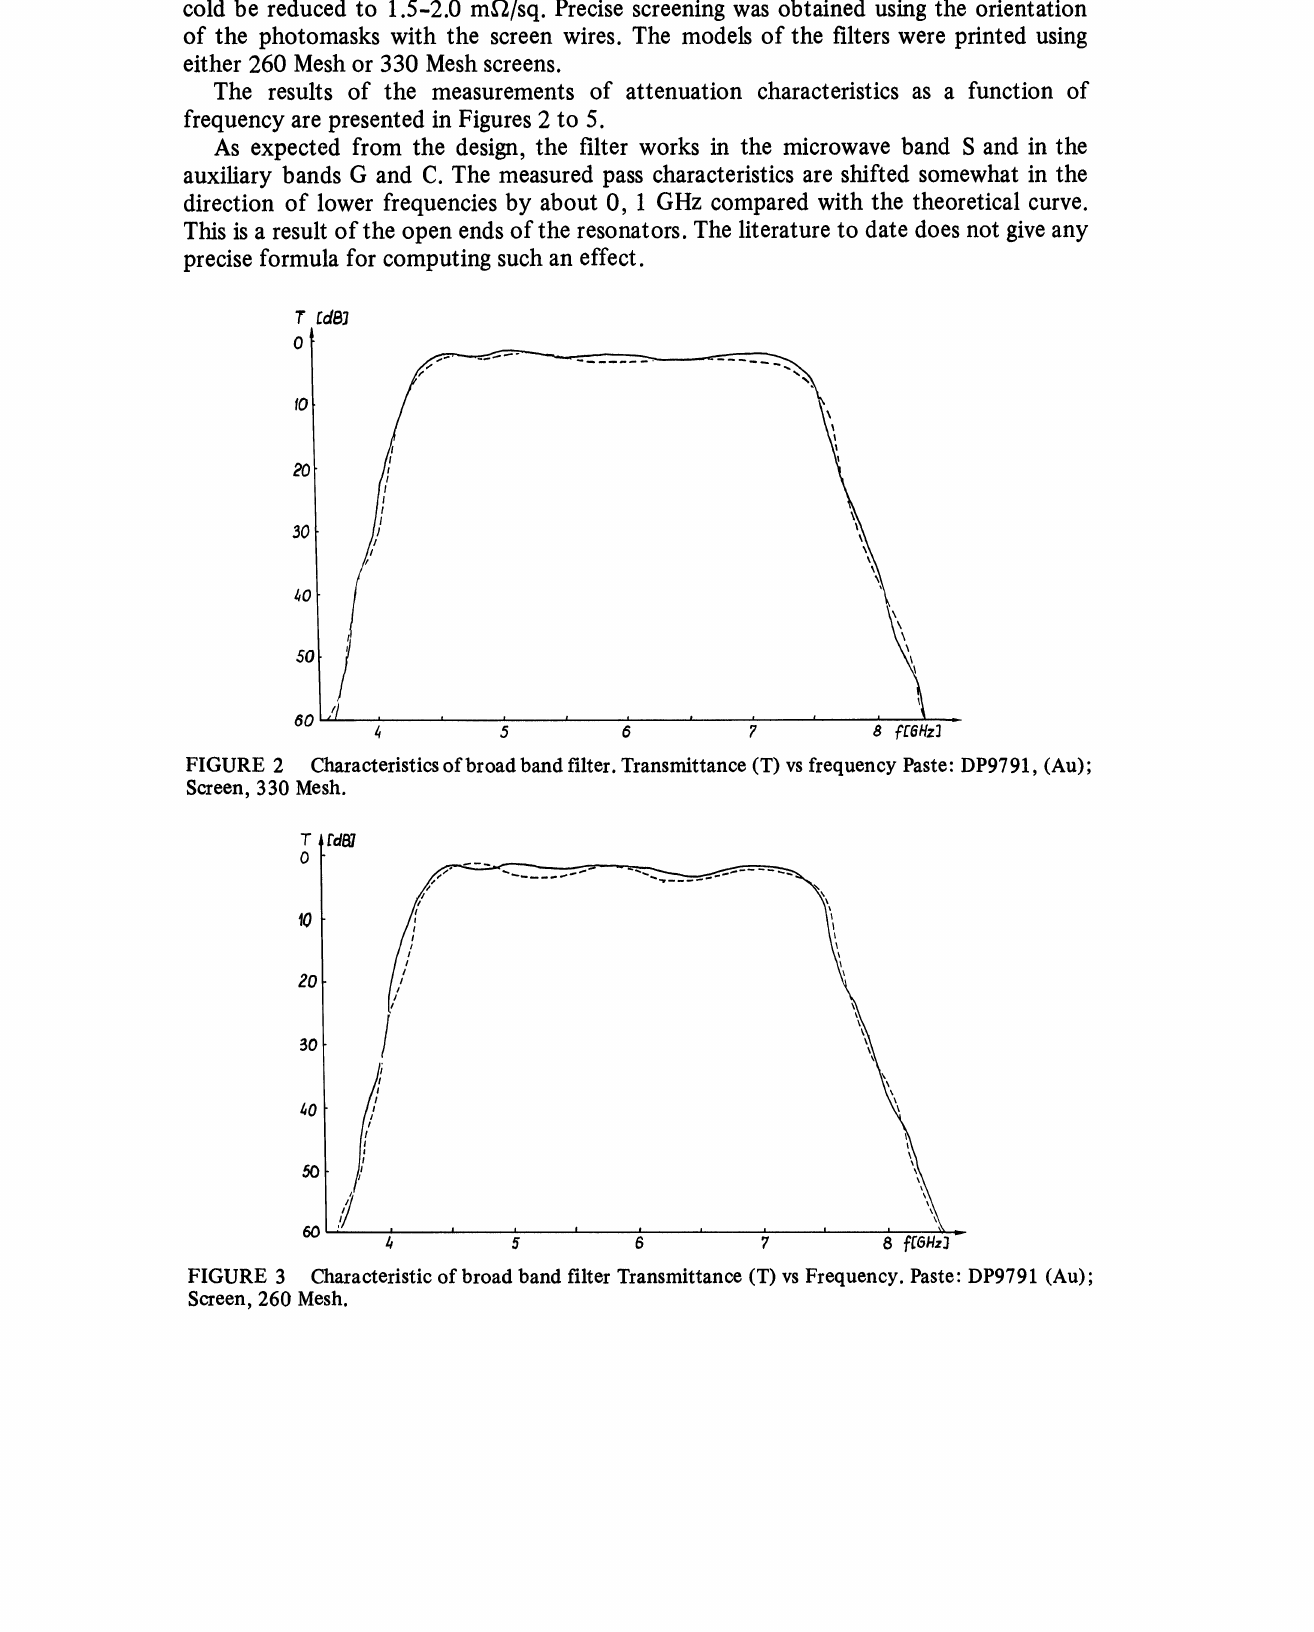
FIGURE 3 Characteristic of broad band filter Transmittance (T) vs Frequency. Paste" DP9791 (Au); Screen, 260